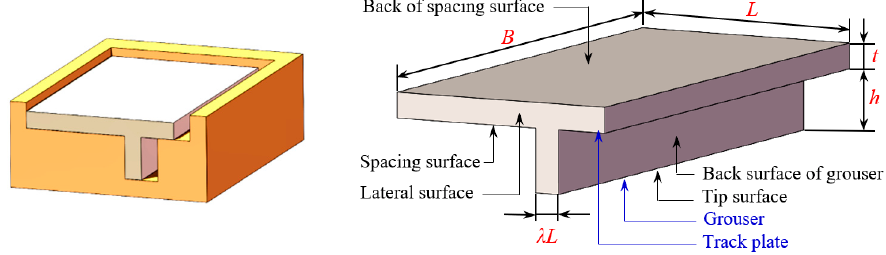
Figure 2. Three-dimensional model of shearing soil of the single-grouser-track shoe. Based on the proposed three-dimensional shearing model, the forces acting on the track shoe model are shown in Figure 3. Under the vertical/normal load of W , the sinkage of the track shoe is z , while the sinkage of the grouser is z + h . The vertical load was determined by the following equation: